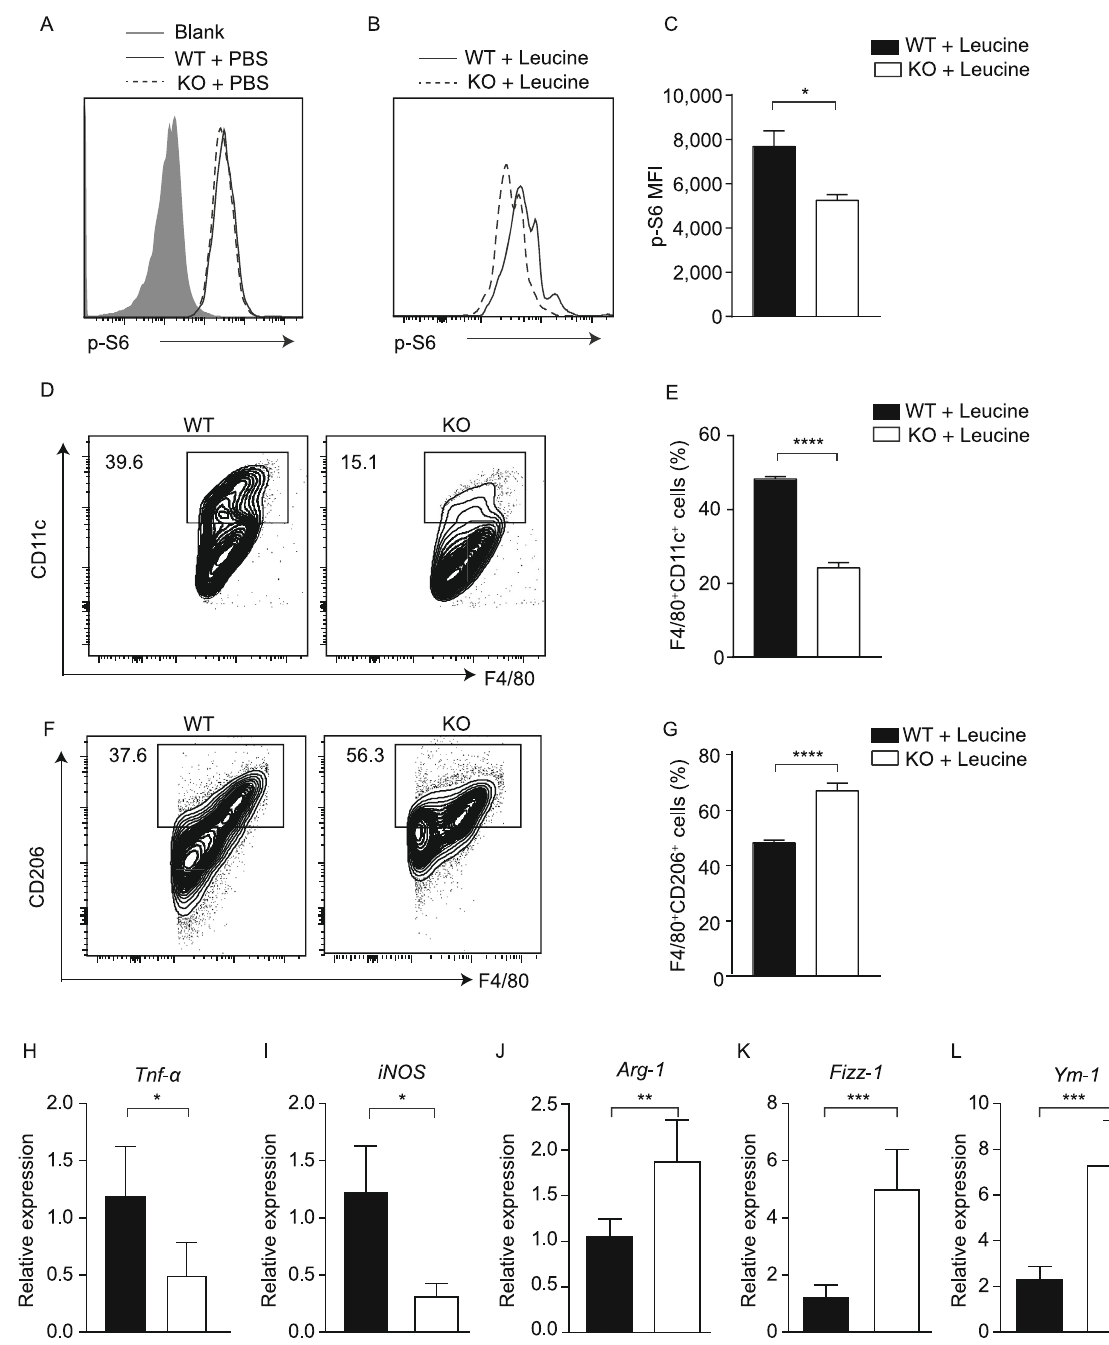
Figure 2. ATP6V0d2 regulates leucine-induced mTORC1 activation and macrophage polarization in vivo . Wild type and Atp6v0d2 − / − mice ( n = 5) were starved for 16 h, and then gavaged with 200 μ L PBS (A) or 200 μ L leucine (54.0 g/L in PBS) (B and C). After 1 h, the S6 phosphorylation of splenic macrophages was determined by fl ow cytometry. Wild type and Atp6v0d2 − / − mice were starved for 16 h, and then gavaged with 200 μ L leucine (54.0 g/L) twice a day for 48 h. After 6 h the last gavage, the expressions of F4/80 and CD11c (D and E) or CD206 (F and G) of splenocytes were determined by fl ow cytometry. The expressions of Tnf-a (H), iNOS (I) , Arginase-1 ( Arg-1 ) (J), Fizz-1 (K) and Ym-1 (L) of F4/80 + macrophages were determined by RT-PCR. Data shown are representative of three independent experiments for leucine-induced mTORC1 activation. Bars = mean ± SEM, * P < 0.05, ** P < 0.01, *** P < 0.005, **** P < 0.0001 (Students ’ s paired t